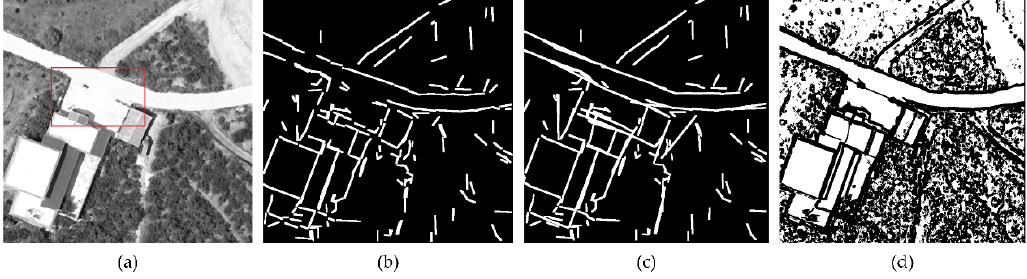
Figure 6. Edge constraints. ( a ) Original map where target road mixes with houses; ( b ) Gabor features by line-segment detection (LSD) analysis; ( c ) connection analysis; ( d ) segmentation with edge